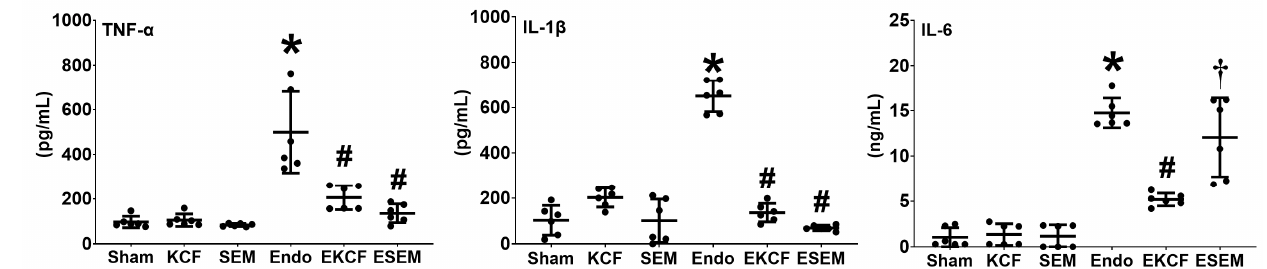
Figure 1. Systemic inflammation status. Plasma concentrations of tumor necrosis factor- α (TNF- α ), interleukin-1 β (IL-1 β ), and interleukin-6 (IL-6) were measured at 24 h after endotoxin or normal saline administration, using enzyme-linked immunosorbent assay. Sham: the normal saline group. KCF: the normal saline plus the KCF18 peptide group. SEM: the normal saline plus the SEM18 pep- tide group. Endo: the endotoxin group; EKCF: the endotoxin plus the KCF18 peptide group. ESEM: the endotoxin plus the SEM18 peptide group. Data were obtained from 6 mice in each group and presented as the mean ± standard deviation. * p < 0.05, versus the Sham group. # p < 0.05, versus the Endo group. † p < 0.05, the ESEM group versus the EKCF group.